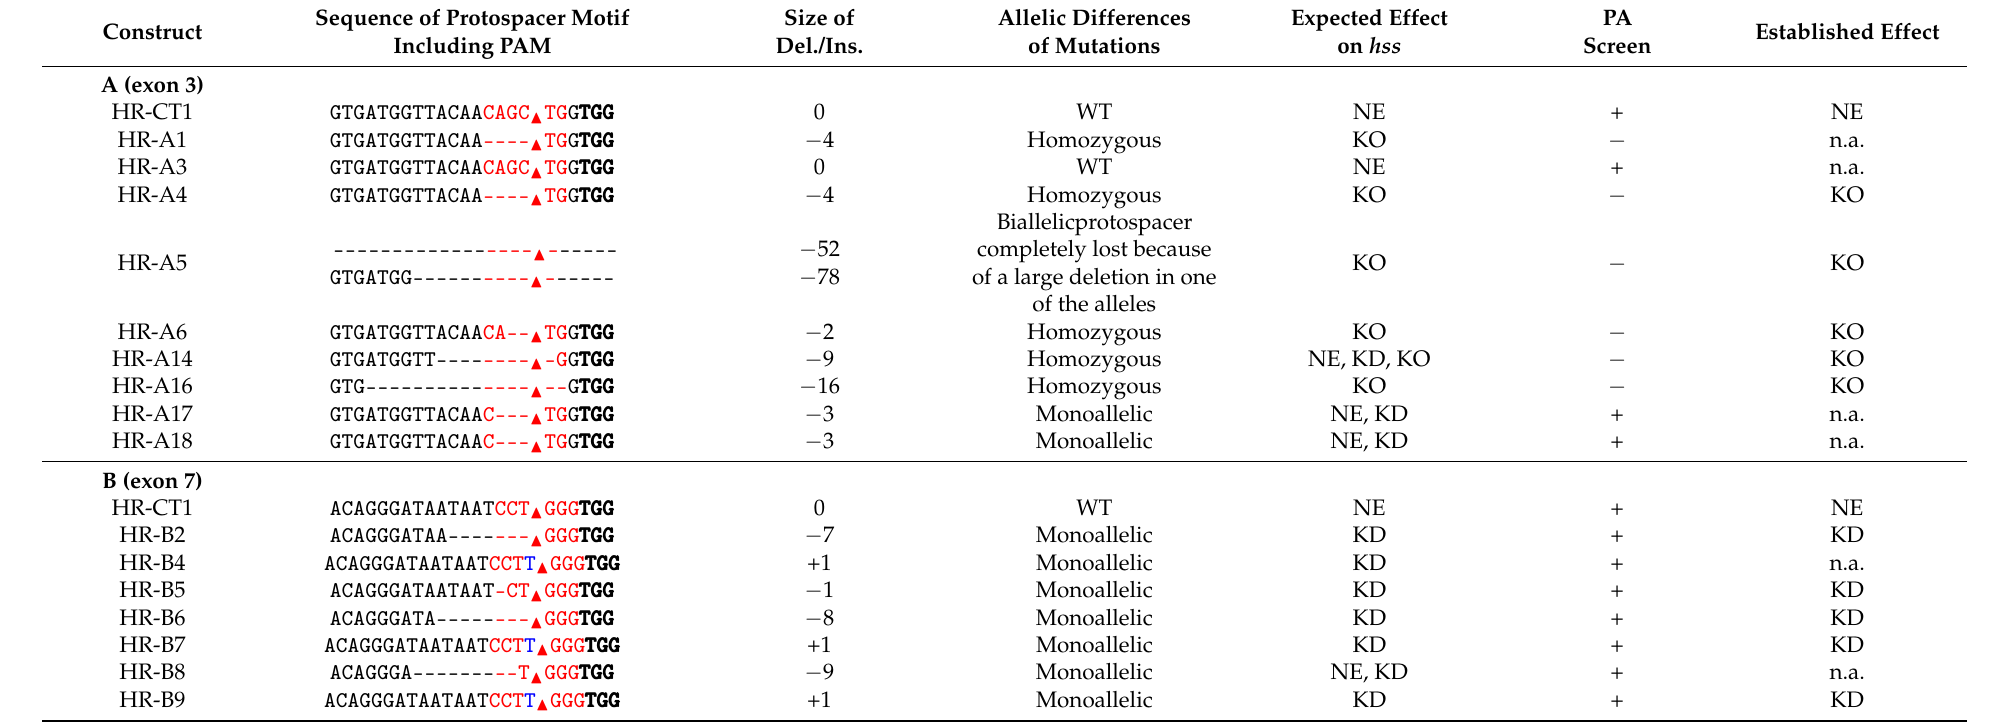
Table 1. Sequence analyses of CRISPR/Cas9-induced mutations by construct A in exon 3 and by construct B in exon 7 of the hss gene in transgenic HRs of comfrey. For all analyzed lines, the 20 nt-long protospacer sequences with the attached PAM motif (TGG, bold) are shown in comparison with the sequence of the hss gene of the control line (HR-CT1) resulting from transformation with the empty vector. The sequence for the hss gene of HR-CT1 is identical to the unmodified hss gene of the wild-type (WT). The recognition sequence motives for the endonucleases Pvu II (A, 5 (cid:48) -CAGCTG-3 (cid:48) ) and Bsa JI (B, 5 (cid:48) -CCNNGG-3 (cid:48) ) are labeled in red. The red arrow head indicates the position, to which Cas9 was directed by the sgRNA in order to introduce the double-strand break. Dashes indicate deletions, blue nucleotides insertions. Predicted effects on the hss gene: KO, knock out, KD, knock down, NE, no editing, n.a., not analyzed. The screen for the presence of PAs refers to only one technical replicate, while established effects are given for lines of which three technical replicates have been analyzed (Figure